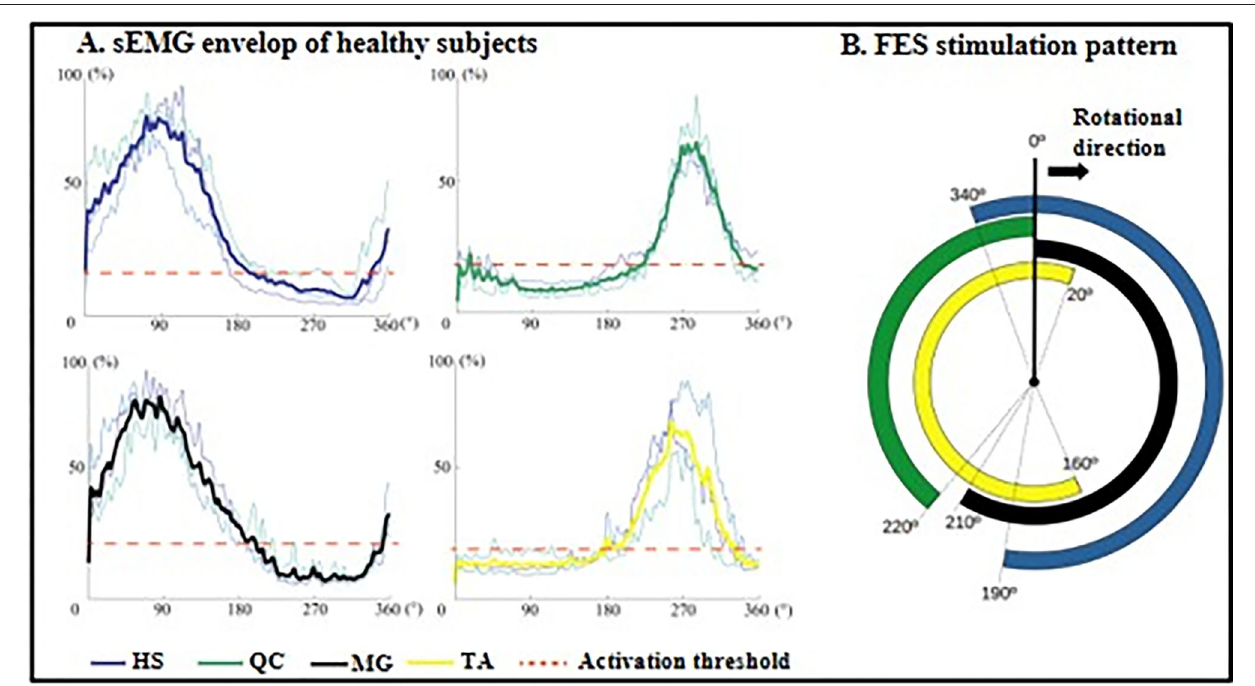
FIGURE 2 | FES stimulation ranges generated from healthy subjects. (A) Mean sEMG envelop of three normal subjects: HS, dark blue; QC, dark green; GL, black; TA, yellow. The red dotted lines are the muscle activation thresholds. The y-axis is the contraction level in the range of 0 to 100% normalized by MVC. (B) FES stimulation pattern within one revolution: four averaged signals mapping periods of stimulation during cycling. HS, hamstrings; QC, quadriceps; MG, medial head of gastrocnemius; TA, tibialis anterior.